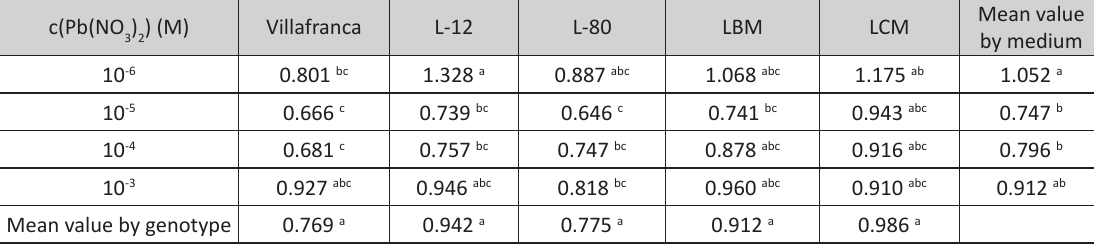
Tolerance index for dry shoot mass production of white poplar on media with examined lead concentrations (LSD – test)